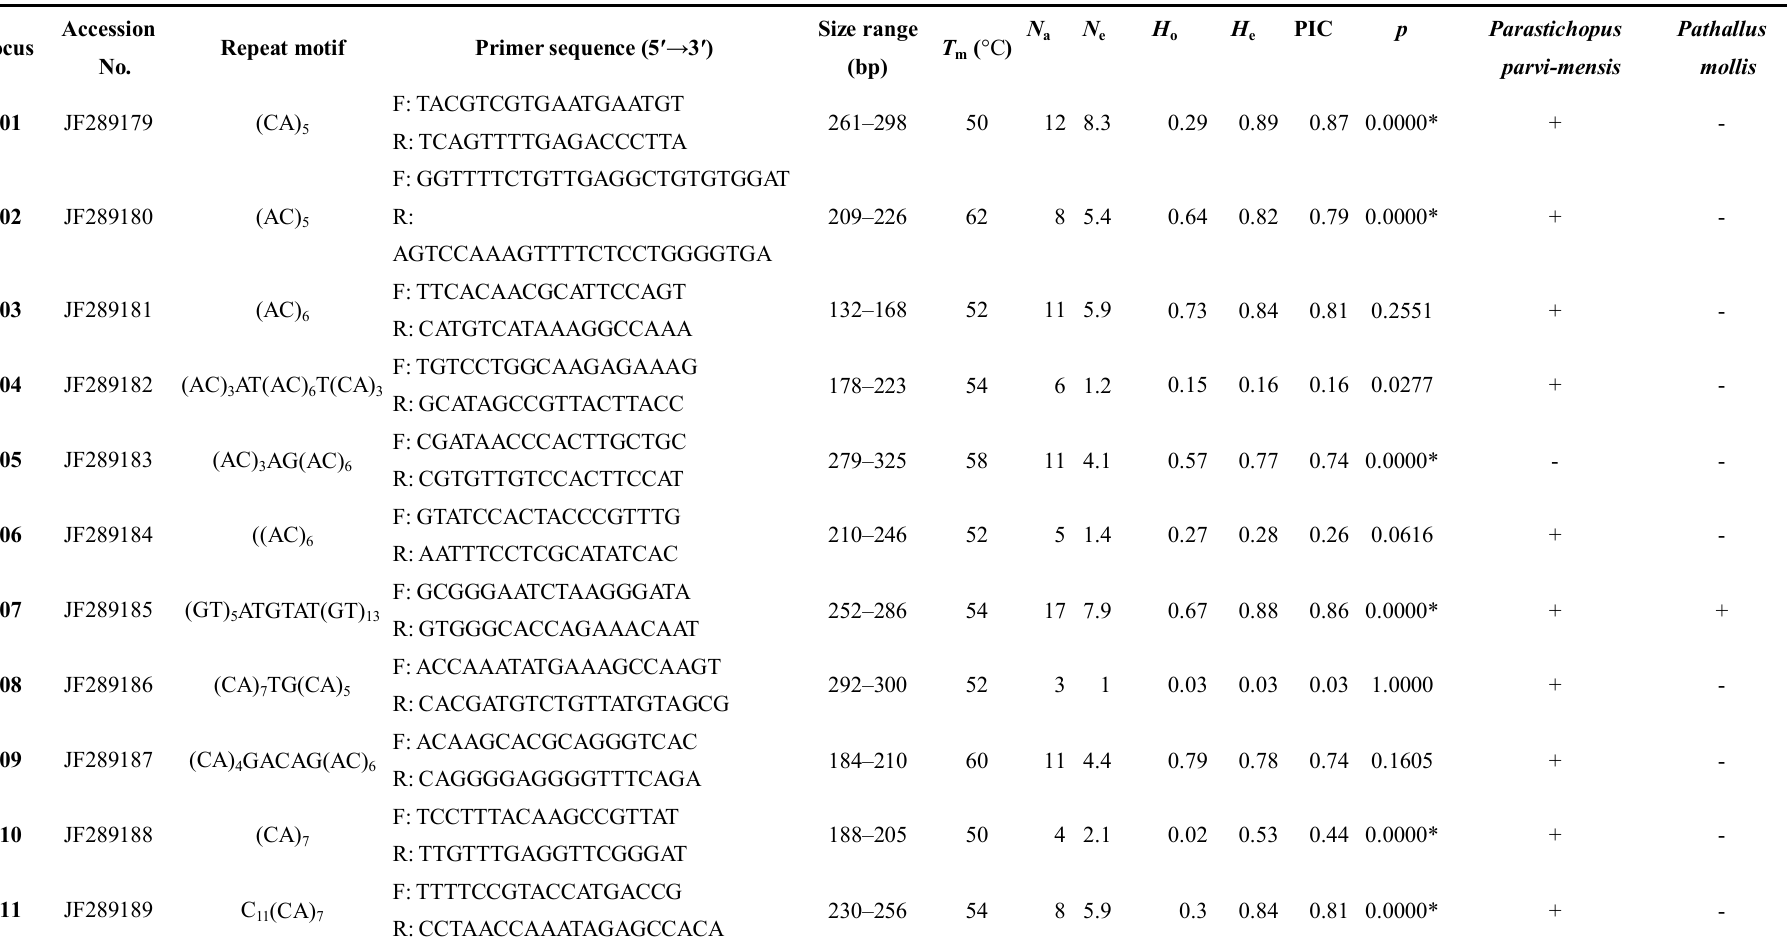
Table 2. Characterization of microsatellite DNA markers developed for sea cucumber ( Apostichopus japonicus ). T temperature (°C); N : allele number; N : effective allele number, H a e PIC: polymorphism index content, p: p value for exact test for Hardy-Weinberg equilibrium (HWE); *: departure from HWE after